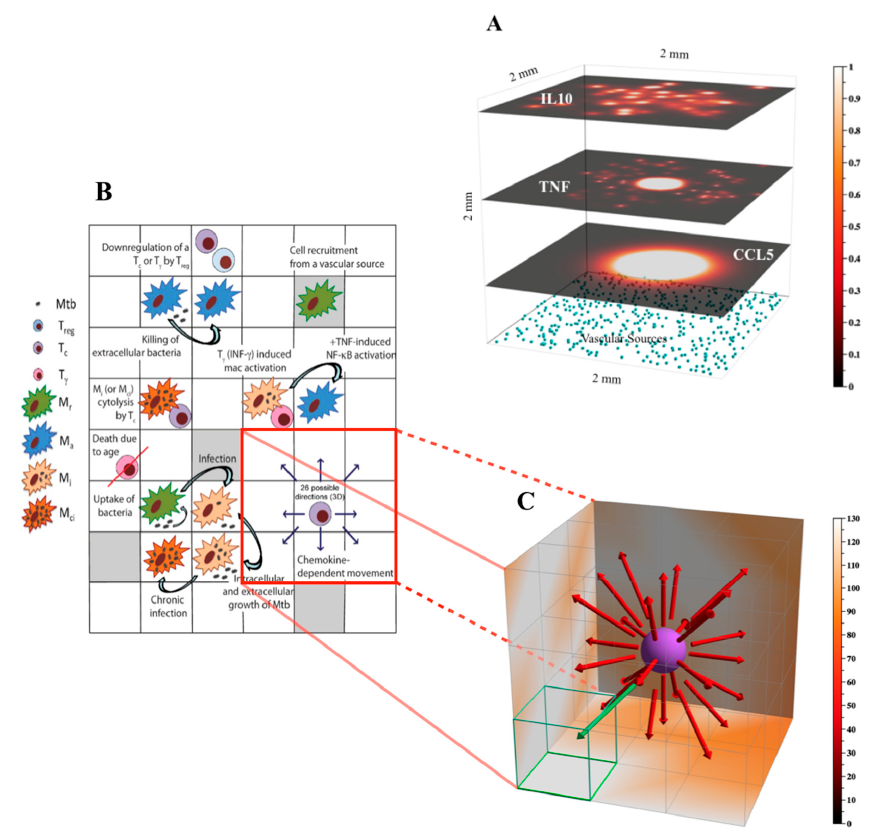
Figure 2. Environment and rules for the 3D version of GranSim . Panel ( A ) Example of molecular diffusion of different molecules in the GranSim environment. The top three layers show three different molecules (top layer—IL-10, middle layer—TNF, lower layer—CCL5) diffusing in a 3D environment of 2 mm 3 with 100 × 100 × 100 microcompartments. The relative concentrations of the molecules in each microcompartment are shown as a heatmap. The three layers correspond to 2D mesh xy-slices at day 32, exp1392 (from our 1500 runs, as described in Section 2.3 Model Calibration and shown in Figure 3), for z-values of 94, 59, and 24, respectively. The xyz-locations of vascular sources (light blue cubes) are also shown, restricted here to those with a z-value of 0. Vascular sources denote sites at which new cells can enter the grid. Shown axes are xyz-positive. Panel ( B ) Schematic describing key agent rules captured in the 3D GranSim model. Panel ( C ) Zoomed-in 3D visualization of a subsection of the 2D schematic shown in ( B ), in which cell movement rules are emphasized. Movement of a simulated cell type (in this case, a cytotoxic T cell, Tc) is dependent on chemokine concentrations, and a cell will either stay in its current compartment or move to one of the neighboring 26 compartments (i.e., its Moore neighborhood). In this example, the green arrow indicates the direction of highest chemokine concentration and thus the most probable direction of cell movement (i.e., to the compartment outlined in